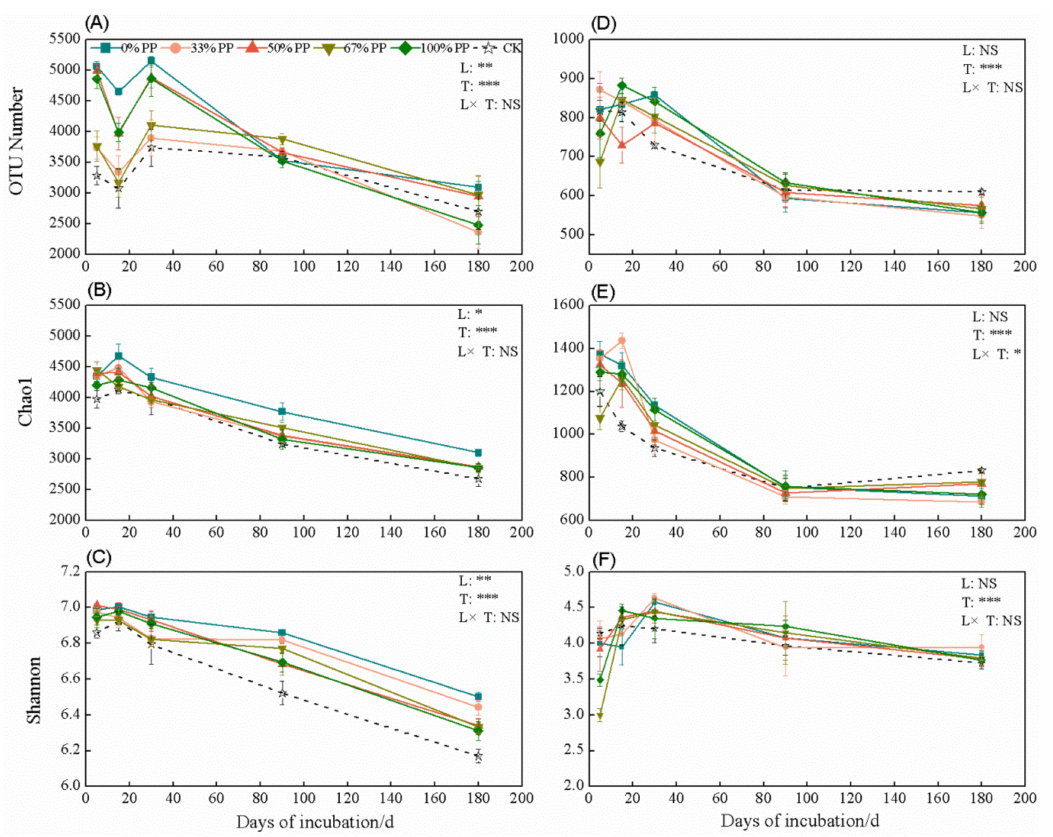
Figure 3. Effects of litter type (0 % PP, 33% PP, 50% PP, 67% PP, 100% PP) on bacterial ( A – C ) and fungal ( D – F ) alpha-diversity. Error bars indicate standard deviation. p -values from RMANOVA on the effects of the litter type (L) and incubation time (T) are also presented. CK, with no litter; 0% PP, bamboo litter occupying at 0%; 33% PP, bamboo litter occupying at 33%; 50% PP, bamboo litter occupying at 50%; 67% PP, bamboo litter occupying at 67%; 100% PP, bamboo litter occupying at 100%. Error bars indicate standard deviation.